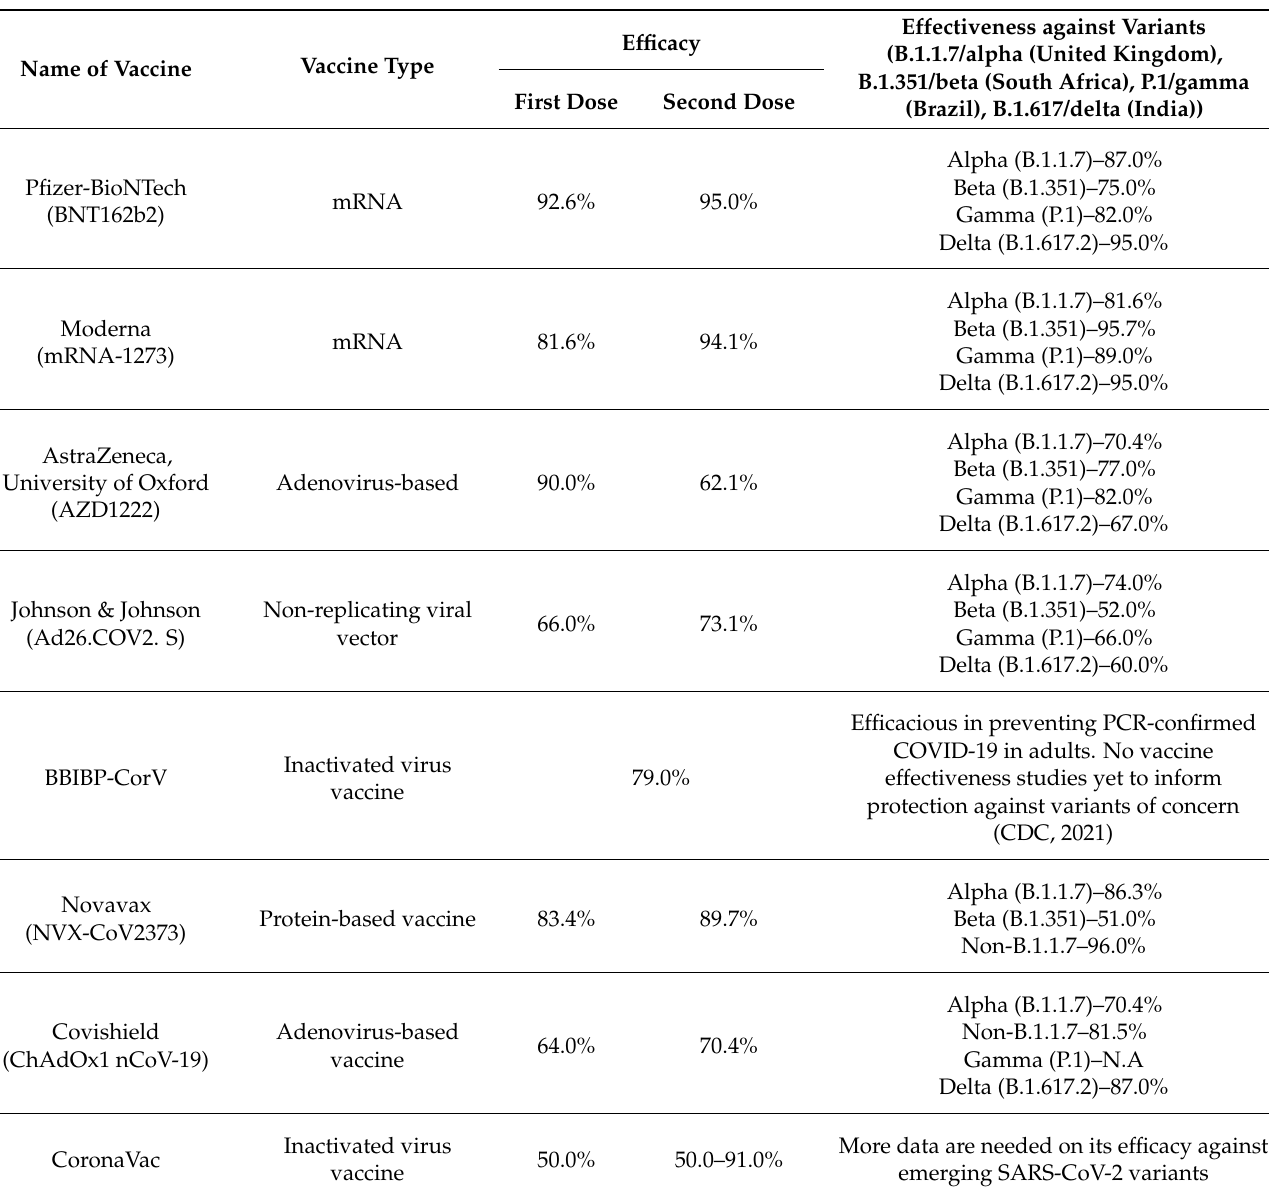
Table 3. Vaccines licensed to date for use against SARS-CoV-2, with their respective efficacies against different variants